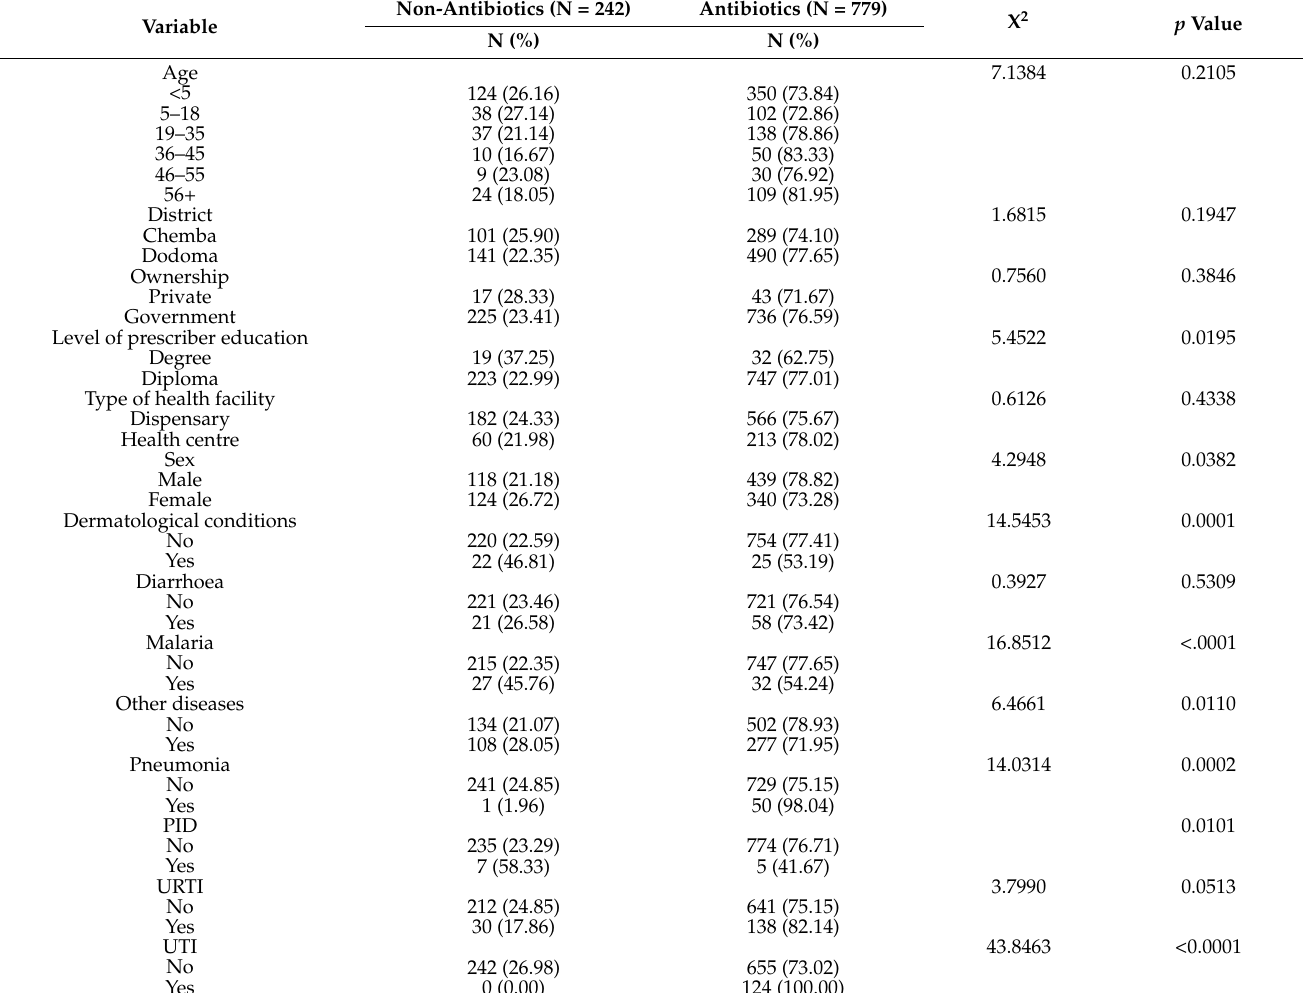
Table 2. Association of antibiotics prescriptions by social, demographic and clinical